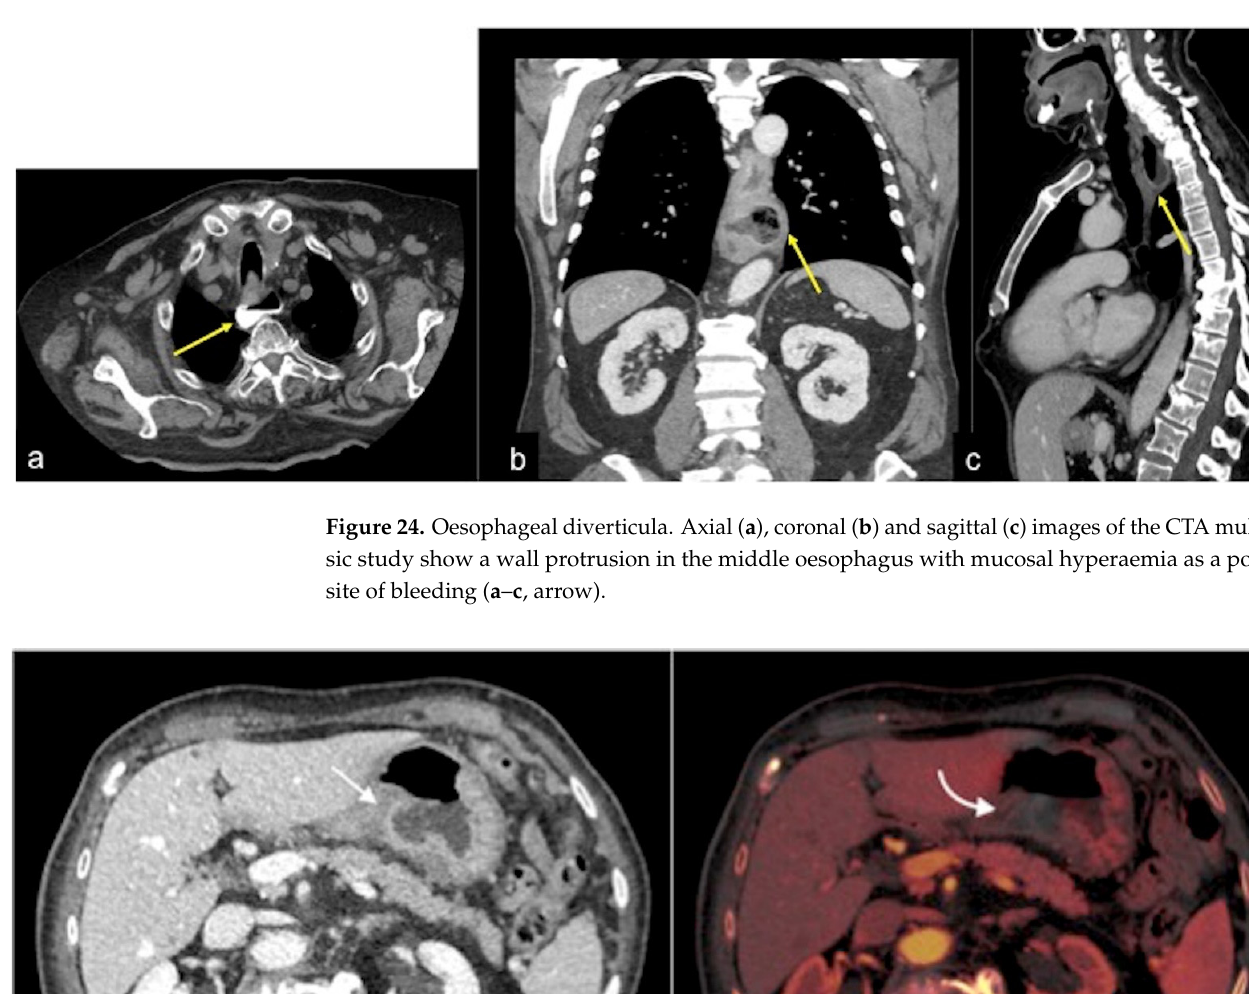
Figure 25. DECTA of peptic ulcer of the stomach. The arterial phase ( a ) and relative iodinated map ( b ) show large ulceration in the gastric body (arrow ( a )) with hyperaemic wall area; no active bleeding signs are demonstrated in the iodinated map (curved arrow ( b )).